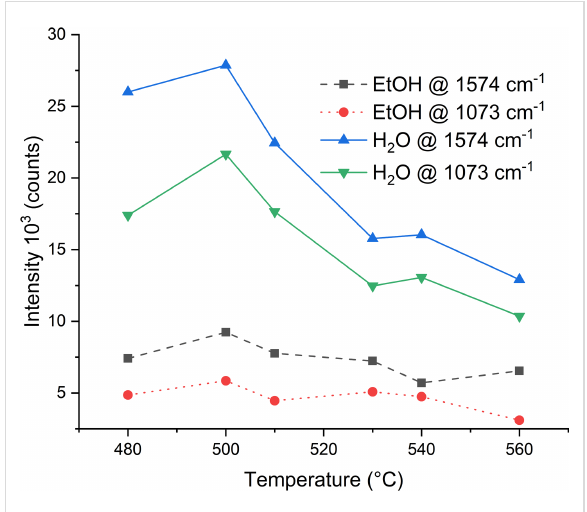
Figure 2: SERS intensities of the 1073 and 1574 cm − 1 bands before (denoted EtOH) and after H 2 O washing for different VLS process tem-